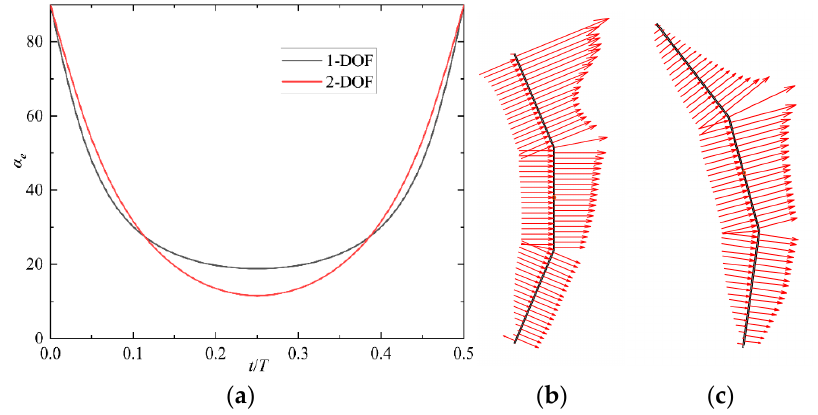
Figure 12. Comparison of 1 and 2-DOF oscillating bent plates in effective AOA and pressure distribution. ( a ) Variations of α e in half cycle. ( b ) Pressure distribution of 1-DOF. ( c ) Pressure distribution of 2-DOF.